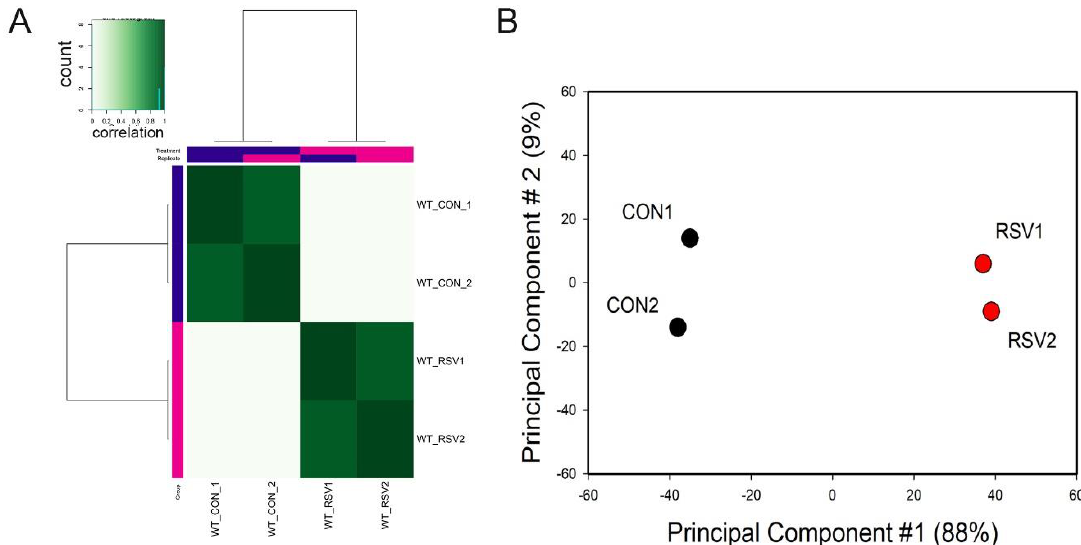
Figure 1. Sample QC. ( A ) Correlation analysis of the assay for transposase-accessible chromatin sequencing (ATAC-Seq) reads for the control and respiratory syncytial virus (RSV)-infected samples. Samples were subjected to hierarchical clustering, with distance indicated in the dendrogram. Note that the individual control (CON) and RSV samples cluster together and the two CON samples are distant from the RSV infected samples. ( B ) Principal Component Analysis. ATAC-Seq peaks were subjected to PCA. X axis, first principal component; Y axis, second principal component. Note the first principal component separates the RSV from the CON treated samples and represents 88% of the variability in the